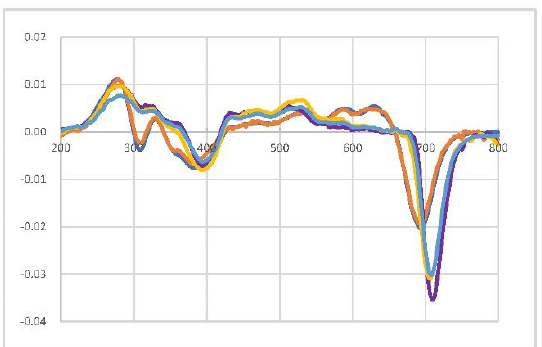
Figure 5. The comparison of the first derivative of MSP absorbance spectra obtained for blue denim fibres from the five experimental fabrics. The results obtained for the fibres constituting the individual fabrics are presented in different colors.